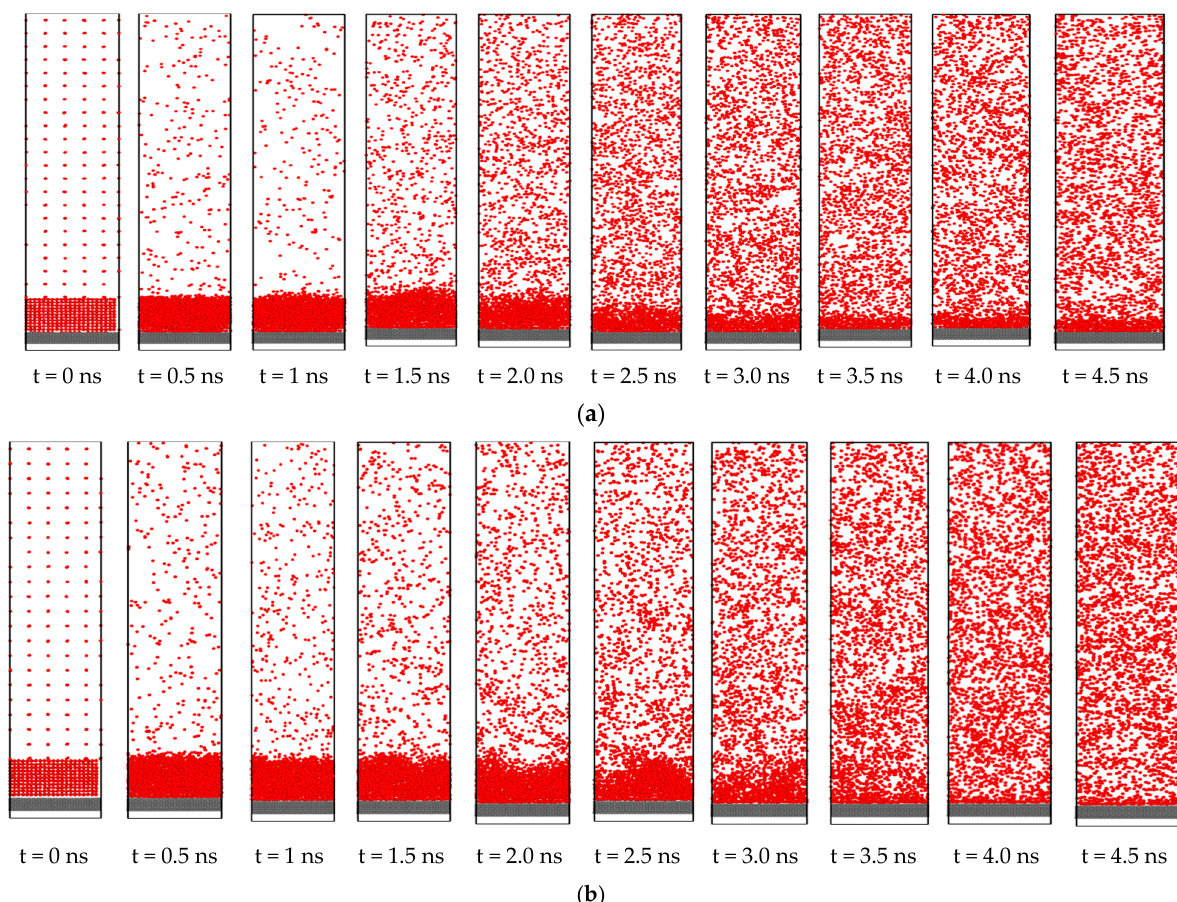
Figure 18. Snapshots from the simulation domain ( x – y plane) for ( a ) surface with nano level roughness, ( b ) smooth surface.